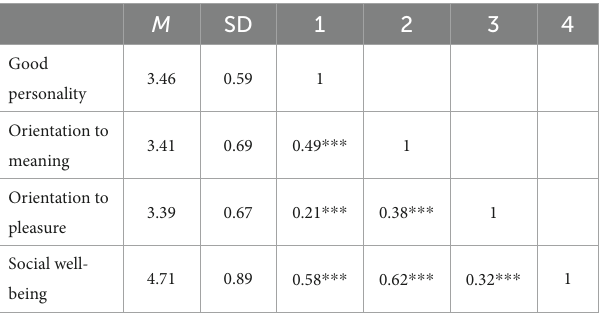
TABLE 1 Analyses of descriptive statistics and correlations ( N = 1,503).